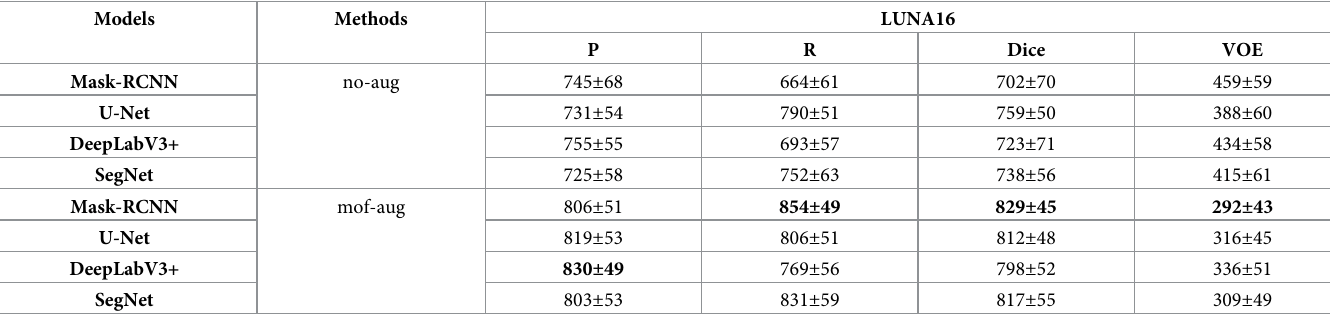
Table 2. Performance of pulmonary nodules segmentation on LUNA16 data